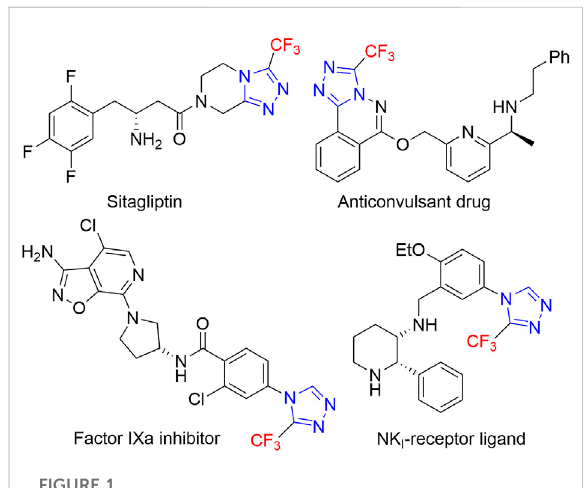
Selected examples of bioactive molecules containing 1,2,4- triazole